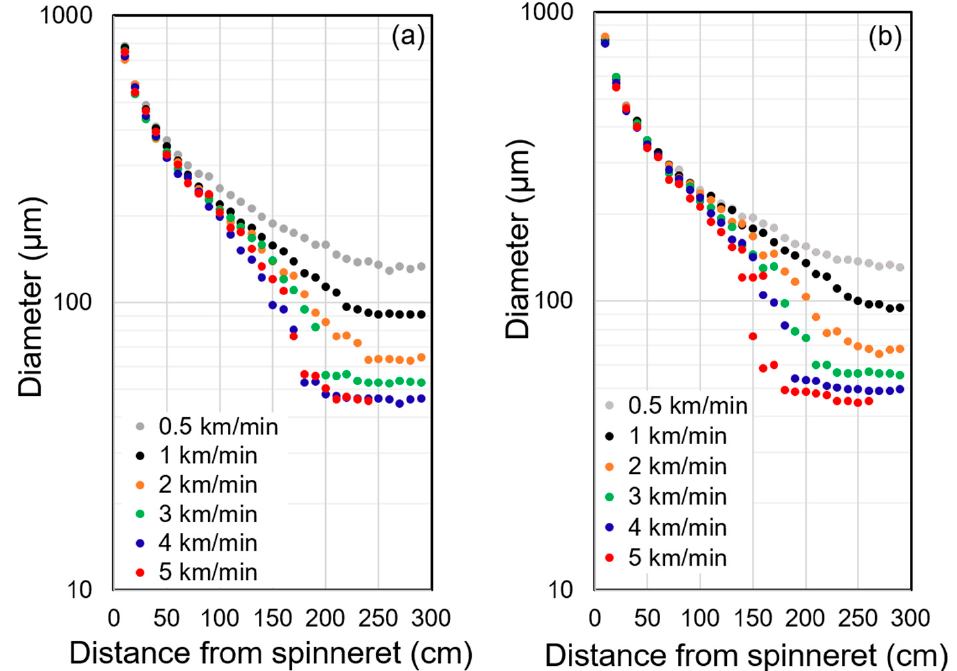
Figure 3. Diameter profiles of the melt spinning line for various take-up velocities; ( a ) virgin PP, ( b ) recycled PP.